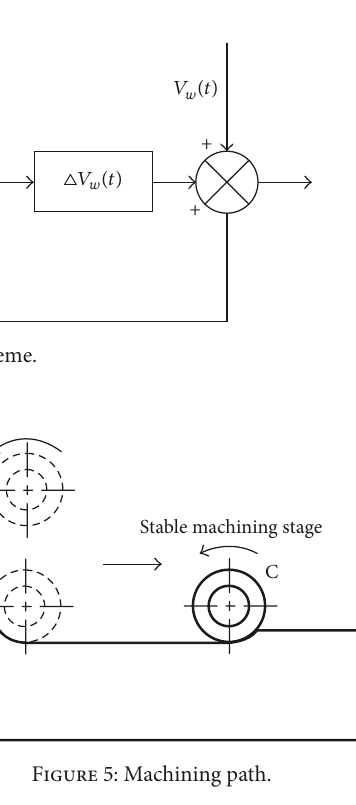
Figure 5: Machining